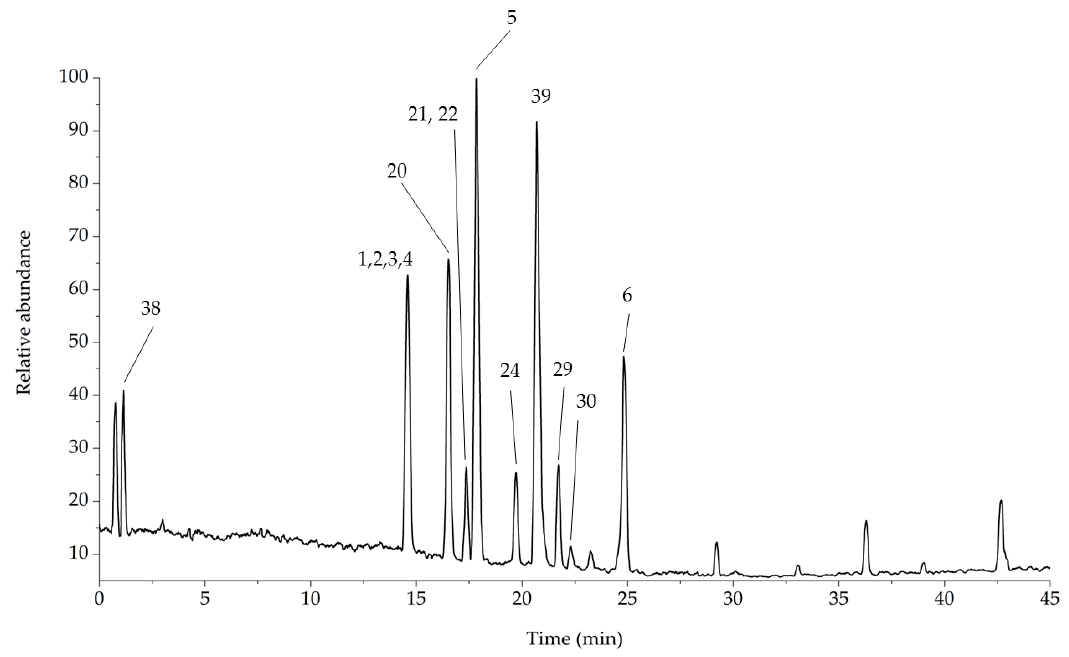
Figure 10. HPLC-ESI(+) chromatogram of coffee leaves extract. The identified compounds are numbered as also reported Table 3.